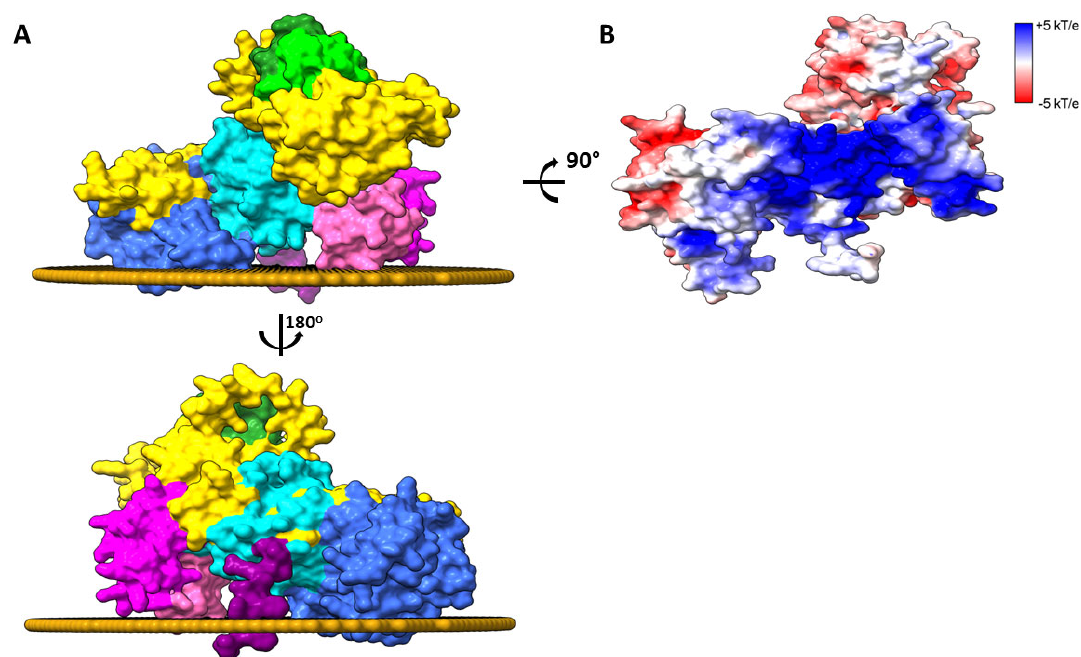
Figure 4. Membrane-bound DGK α . ( A ) The spatial arrangement of the AlphaFold predicted structure of human DGK α bound to the eukaryotic plasma membrane was done with PPM 3.0 [47]. Residues in C1 and accessory domains as well as the Pro segment anchors the enzyme to the membrane interface. Only the membrane leaflet interacting with the enzyme is shown. Structures were generated using Chimera X [26] and domains colored as follows: EF hand 1 (residues 114–142, lime), EF hand 2 (residues 159–187, forest green), C1A (residues 206–253, hot pink), C1B (residues 268–319, magenta), catalytic (residues 376–500, dark turquoise), accessory (residues 520–701, royal blue), and Pro (residues 722–735, purple). The remaining protein was colored in gold. ( B ) The surface of the enzyme interacting with the membrane is shown and colored by Electrostatic surface potential (ESP, red = acidic, white = neutral, and blue = basic surfaces). The membrane leaflet interacting with the enzyme was removed for clarity.